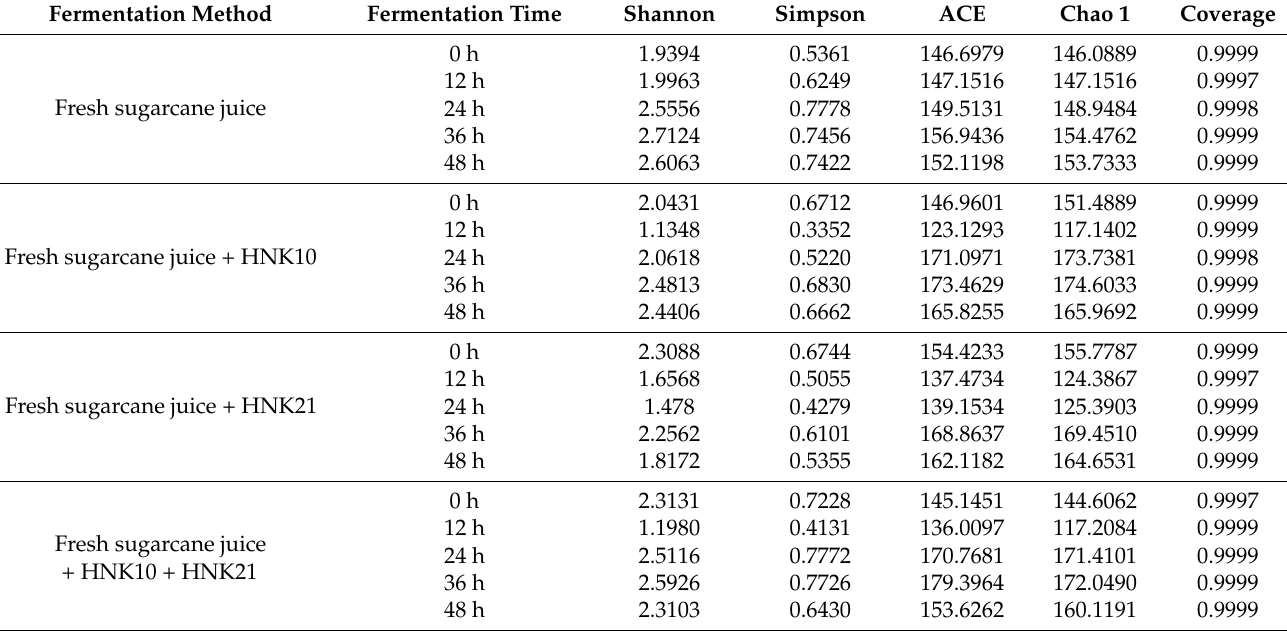
Table 1. Diversity index of microorganisms in fermented sugar cane